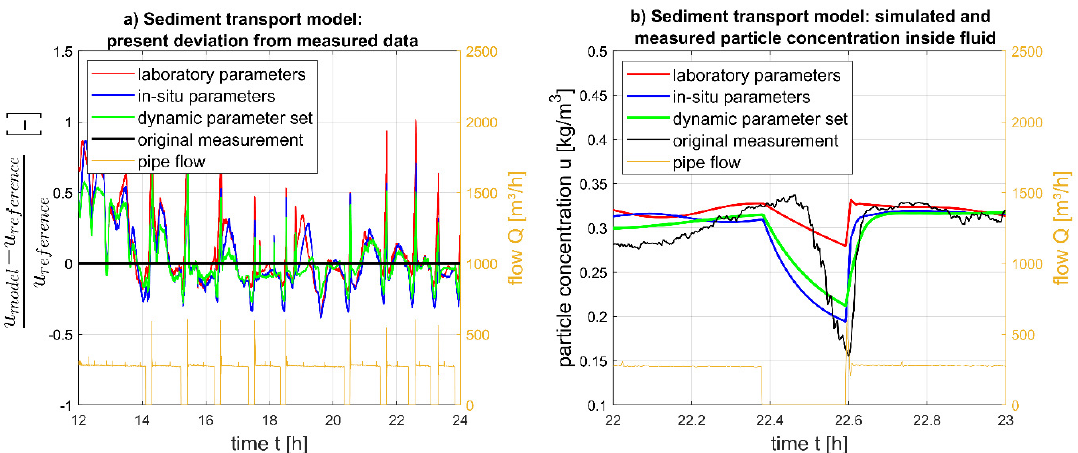
Figure 4. Results of the sediment transport simulation. ( a ) present deviation from all three simulated parameter sets. ( b ) settling sequence detail.